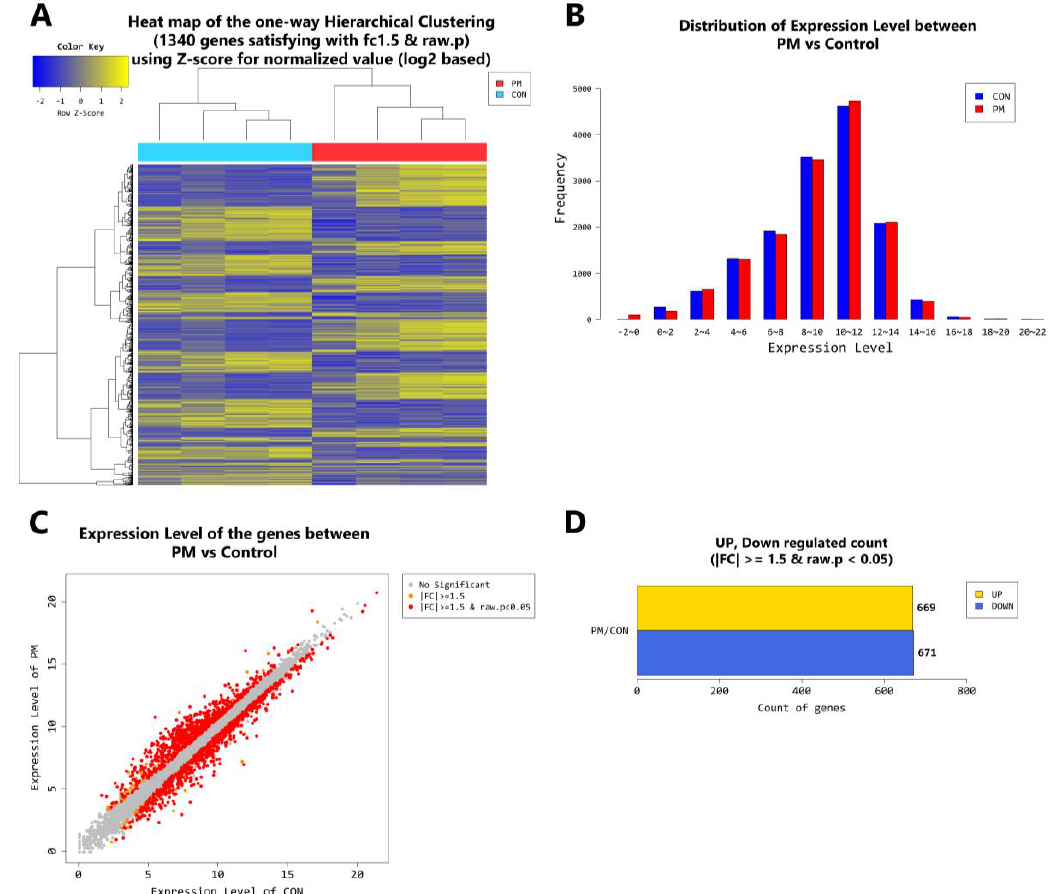
Figure 7. ( A ) Heat map of the one-way hierarchical clustering (PM old vs. control old). ( B ) Distribution of gene expression level between PM-exposed and control old dermal fibroblasts. ( C ) Scatter plot of gene expression level. ( D ) Significant gene count by fold change and p -value. n = 4 in each group (PM old, control old). Only those genes exhibiting log 2 fold change (FC) > 1.5 and p < 0.05 were considered as differentially expressed genes. For DEG (differentially expressed gene) set, hierarchical clustering analysis was done with complete linkage and Euclidean distance as a measure of